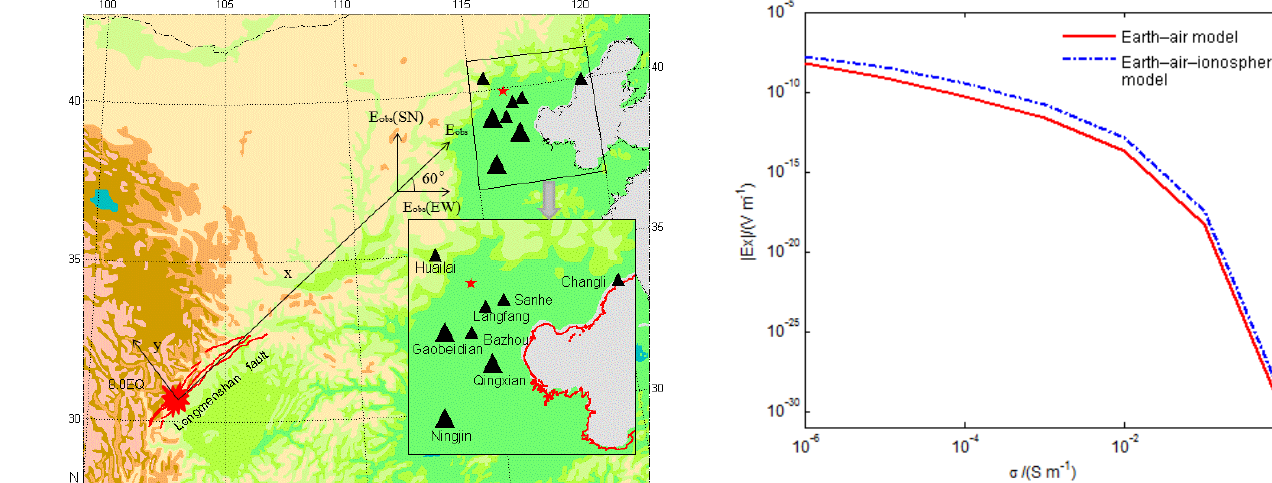
Figure 5. Distribution of the Wenchuan earthquake epicenter and observation stations. Black solid triangles present the related loca- tions of observation stations in Hebei electromagnetic observation network, bigger ones indicate the stations where abnormal informa- tion was recorded and the red star denotes Beijing (Li et al., 2013, Fig. 1). A ground surface coordinate system is added.